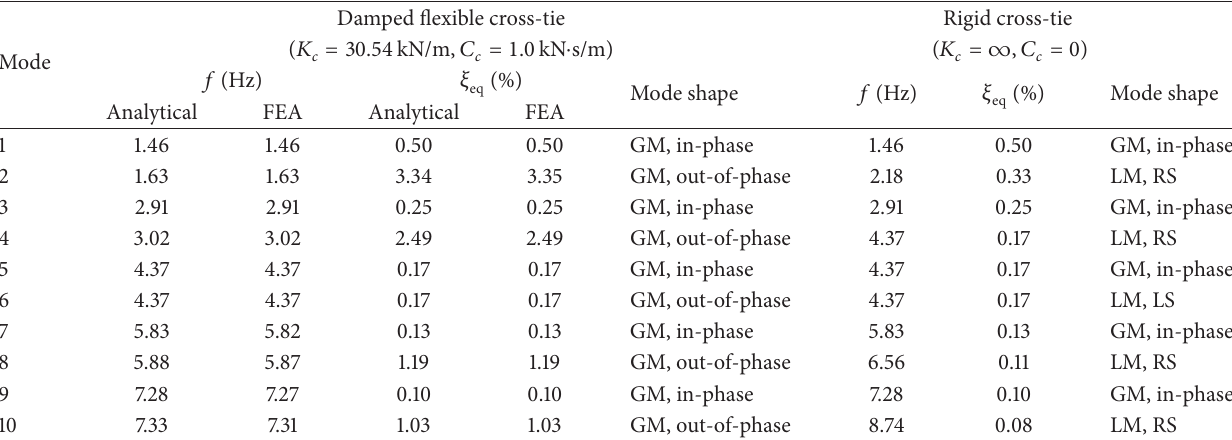
Table 1: Comparison of modal properties of a twin-cable network with damped flexible or rigid cross-tie at 𝜀 = 1/3 . Damped flexible cross-tie Rigid cross-tie Mode Mode shape Mode shape Analytical